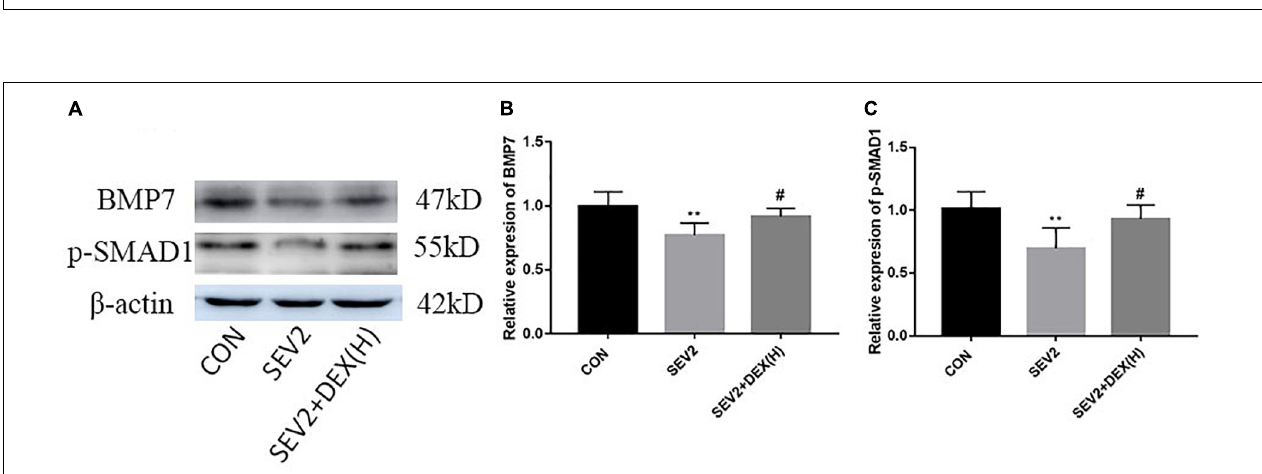
FIGURE 5 | The BMP7/SMAD1 pathway was involved in the neuroprotective mechanism of Dex against sevoflurane. Representative Western blots for the expression levels of BMP7 and p-SMAD1 at P1 (A) . Quantification of BMP7 (B) and p-SMAD1 (C) normalized to β -actin. Data are expressed as the mean ± SEM ( n = 6 in each group). Comparisons were made using one-way ANOVA and post hoc Tukey’s correction. ∗∗ P < 0.01, compared to the CON group; # P < 0.05, compared to the SEV2 group.